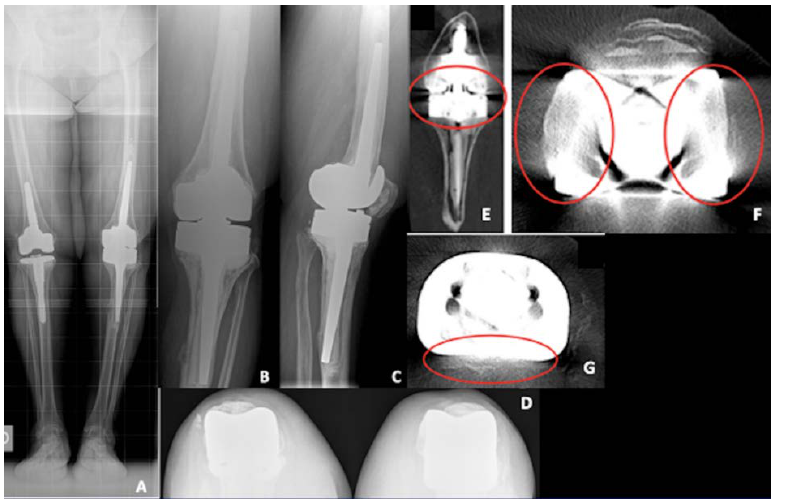
Figure 6. Pre-operative X-rays of the re-revision TKA case. ( A ) Long-leg weight bearing view; ( B ) antero-posterior view; ( C ) lateral view; ( D ) patellar view; ( E ) coronal view of a computer tomogra- phy (CT) scan demonstrating tibial bone loss (red circle); ( F ) coronal view of a CT scan demonstrating femoral artifacts (red circle); ( G ) axial view of a CT scan demonstrating tibial artifacts (red circle).